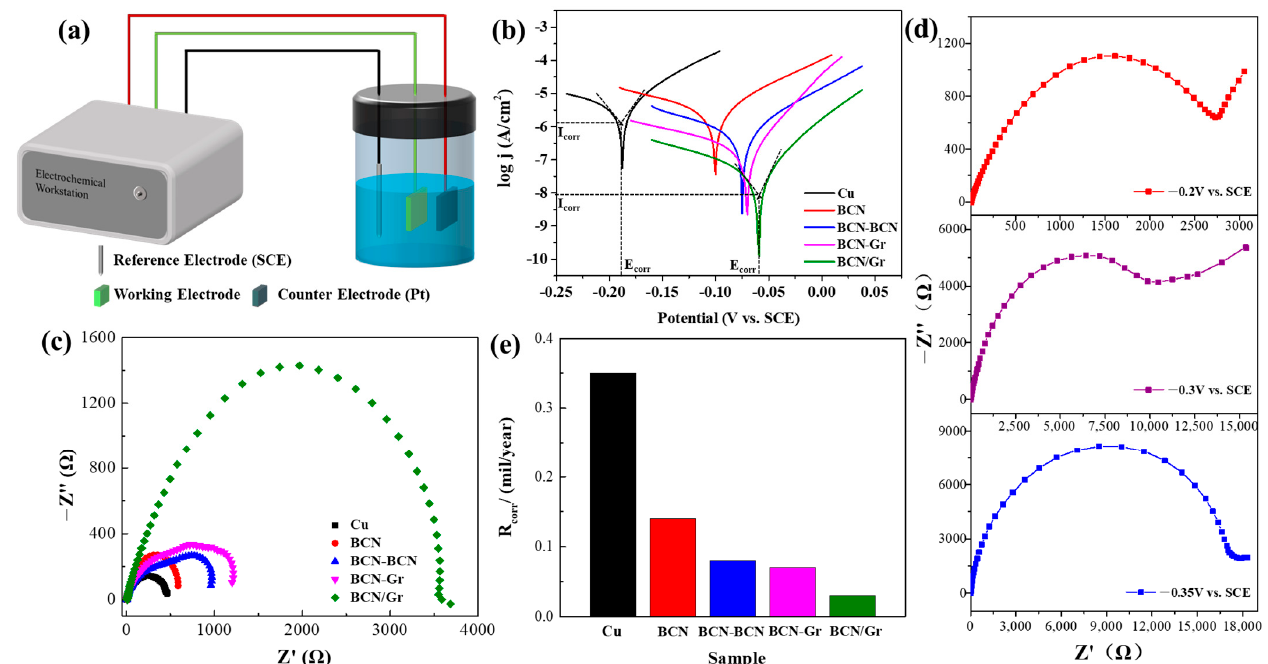
Figure 4. ( a ) Schematic diagram of the three-electrode system for electrochemical testing; ( b ) Tafel curves of the Cu foils with different modification layers; ( c ) Nyquist diagram obtained by electrochemical impedance spectroscopy of the different samples; ( d ) potential dependent EIS results of in-situ grown BCN/Gr 2D films; ( e ) Corrosion rates of the samples with different surface modification.